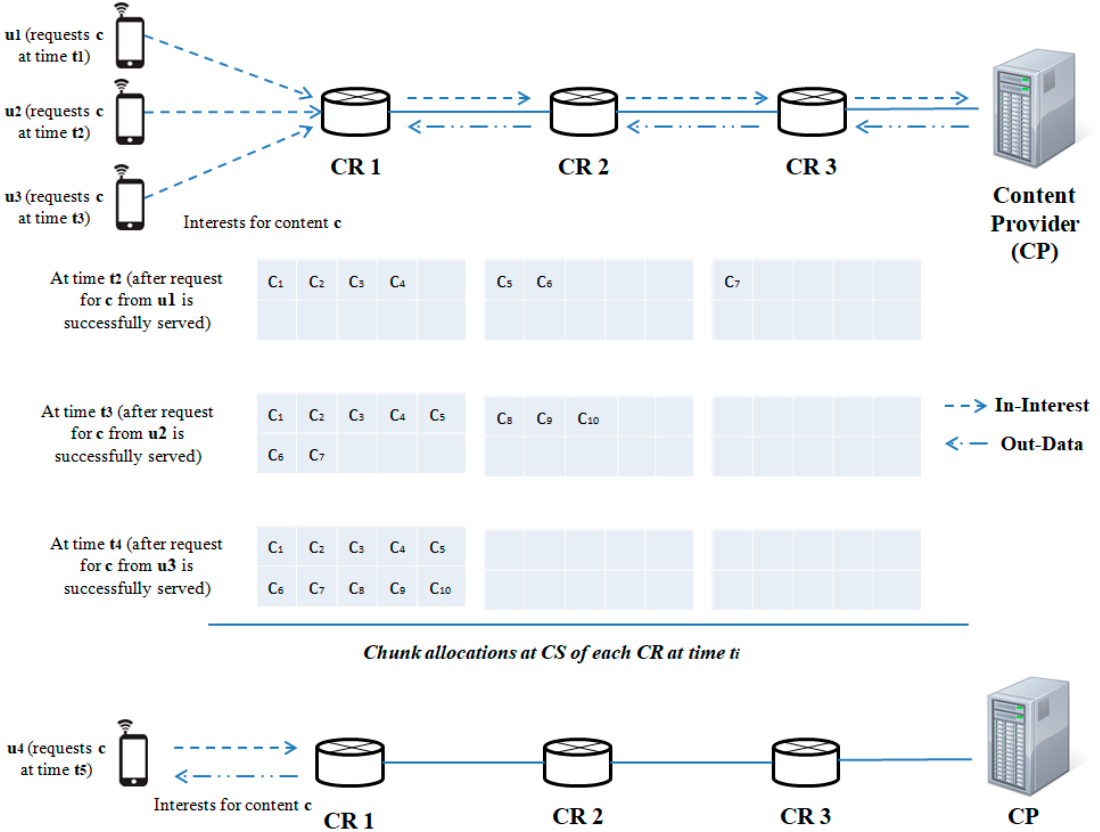
Figure 2. Use-case for caching decision strategies of PPCS.